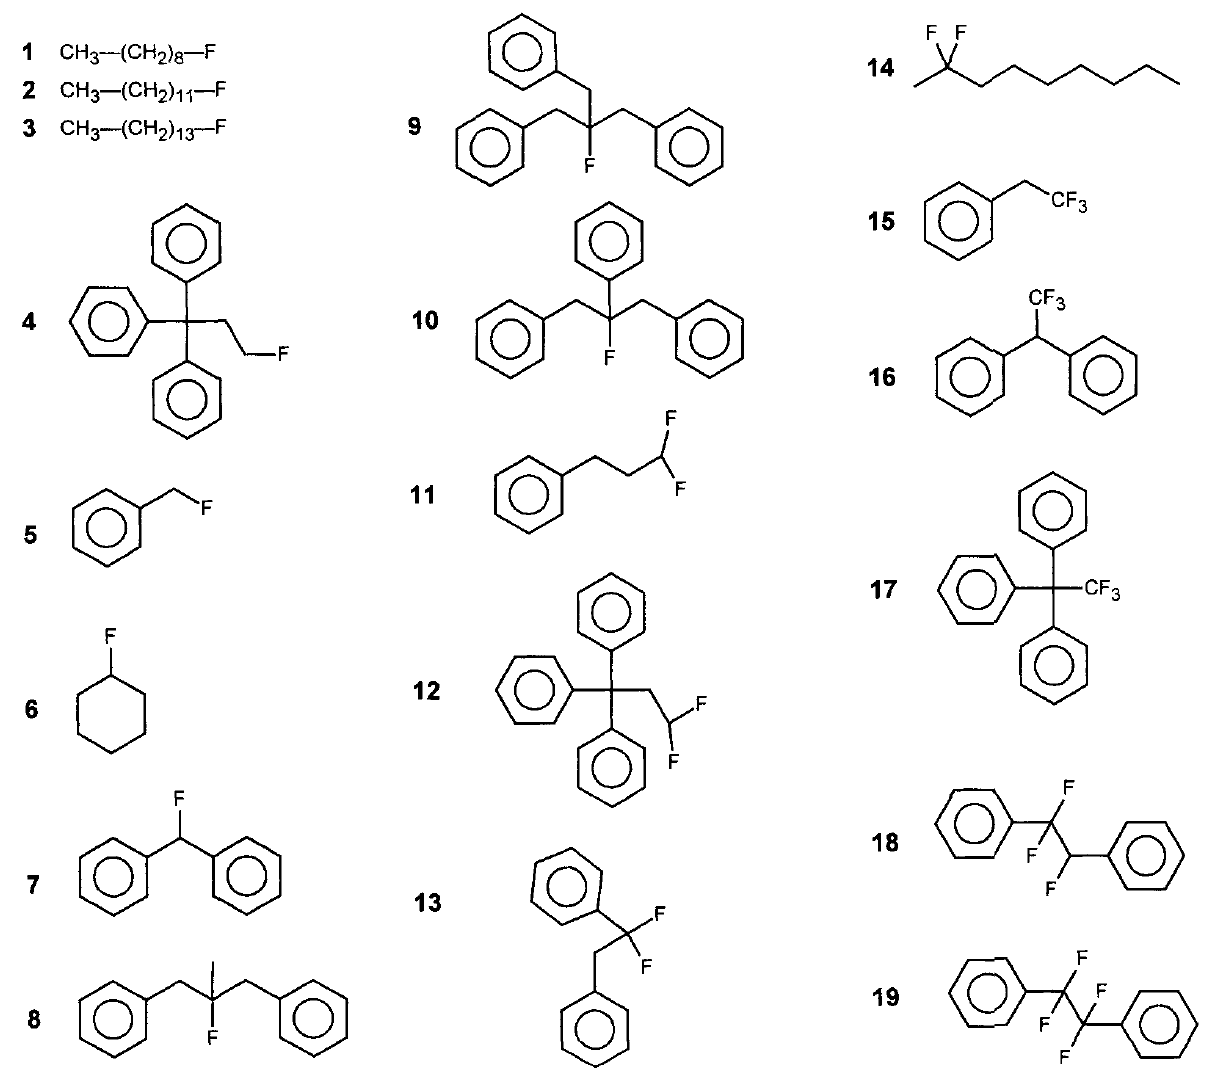
Table 4. Experimental and model values for fluoroalkanes. All values in kJ/mol. Most experimental values were taken from [23] and some more from [24,25]; for comments, see the text. The corrections (corr.) in column 5 only apply to species involving 1,1- or 1,2-difluoro interactions; for an explana- tion, see the